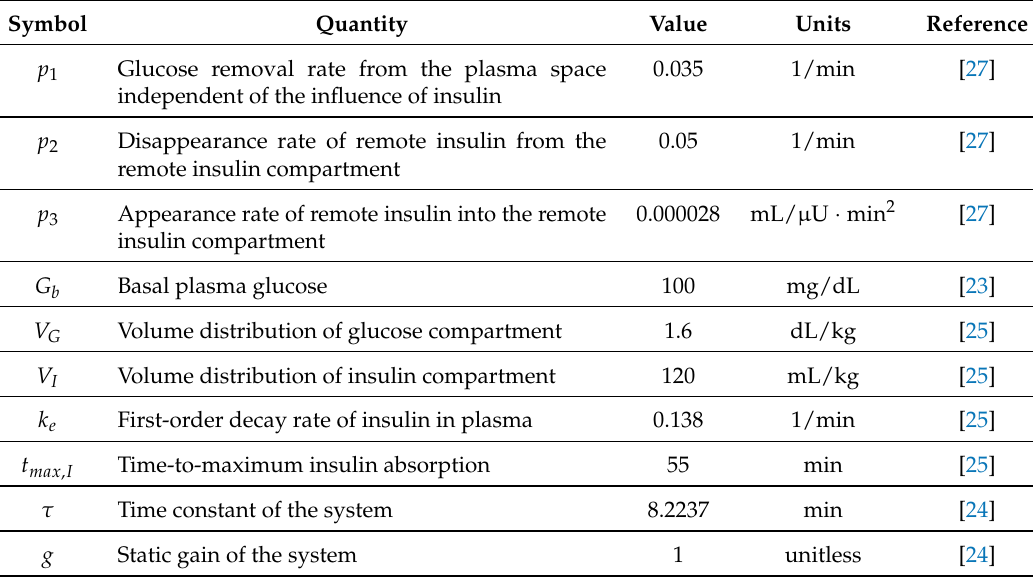
Table 1. Mean population parameter